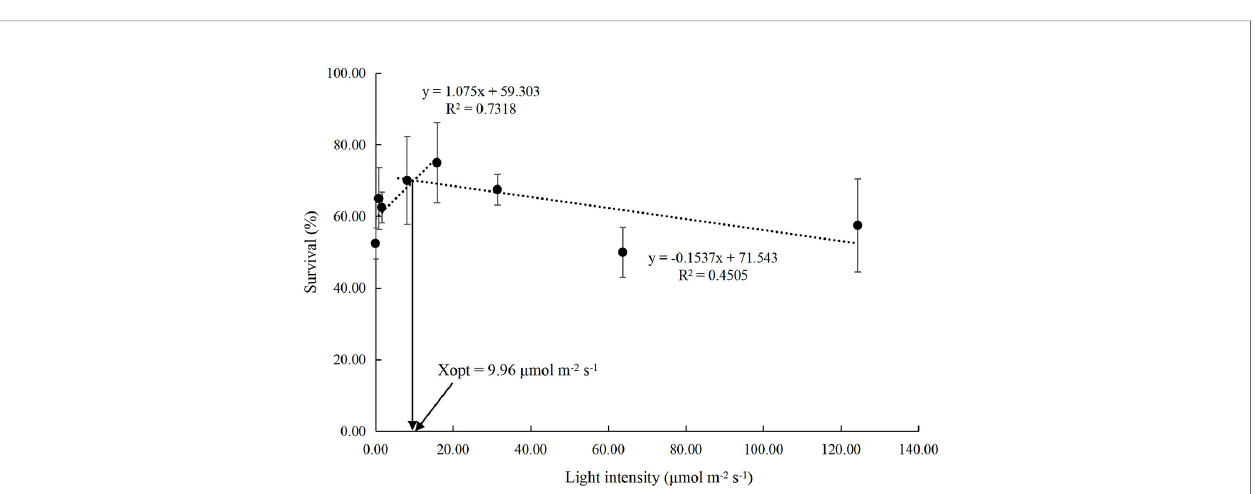
FIGURE 3 | Relationship between light intensity and survival in juvenile Portunus trituberculatus (mean ± SD, n = 4) based on linear models, where Xopt represents the optimal light intensity for the maximum survival.